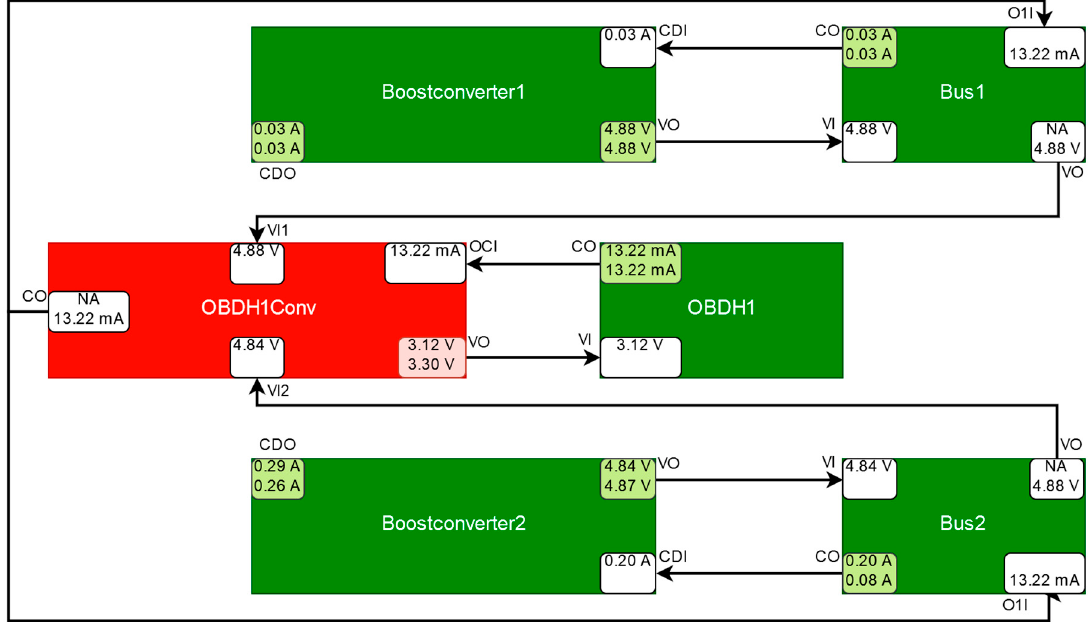
Figure 24. Simplified schematic depiction of the suspected component OBDH1Conv and its relevant surrounding components (explanation see Figure 20).